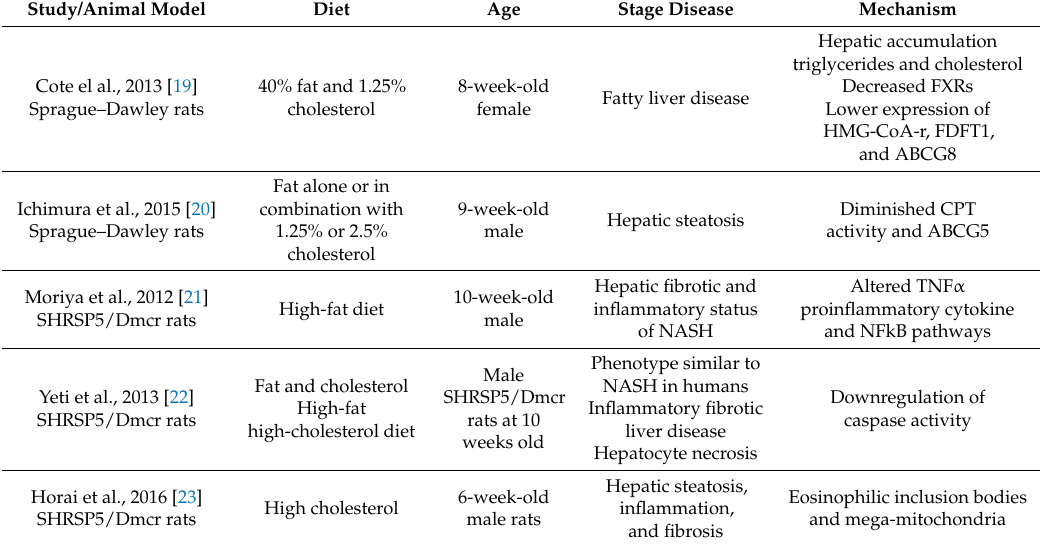
Table 1. Impact of dietary cholesterol in rat models of non-alcoholic fatty liver disease (NAFLD) and non-alcoholic steatohepatitis (NASH).